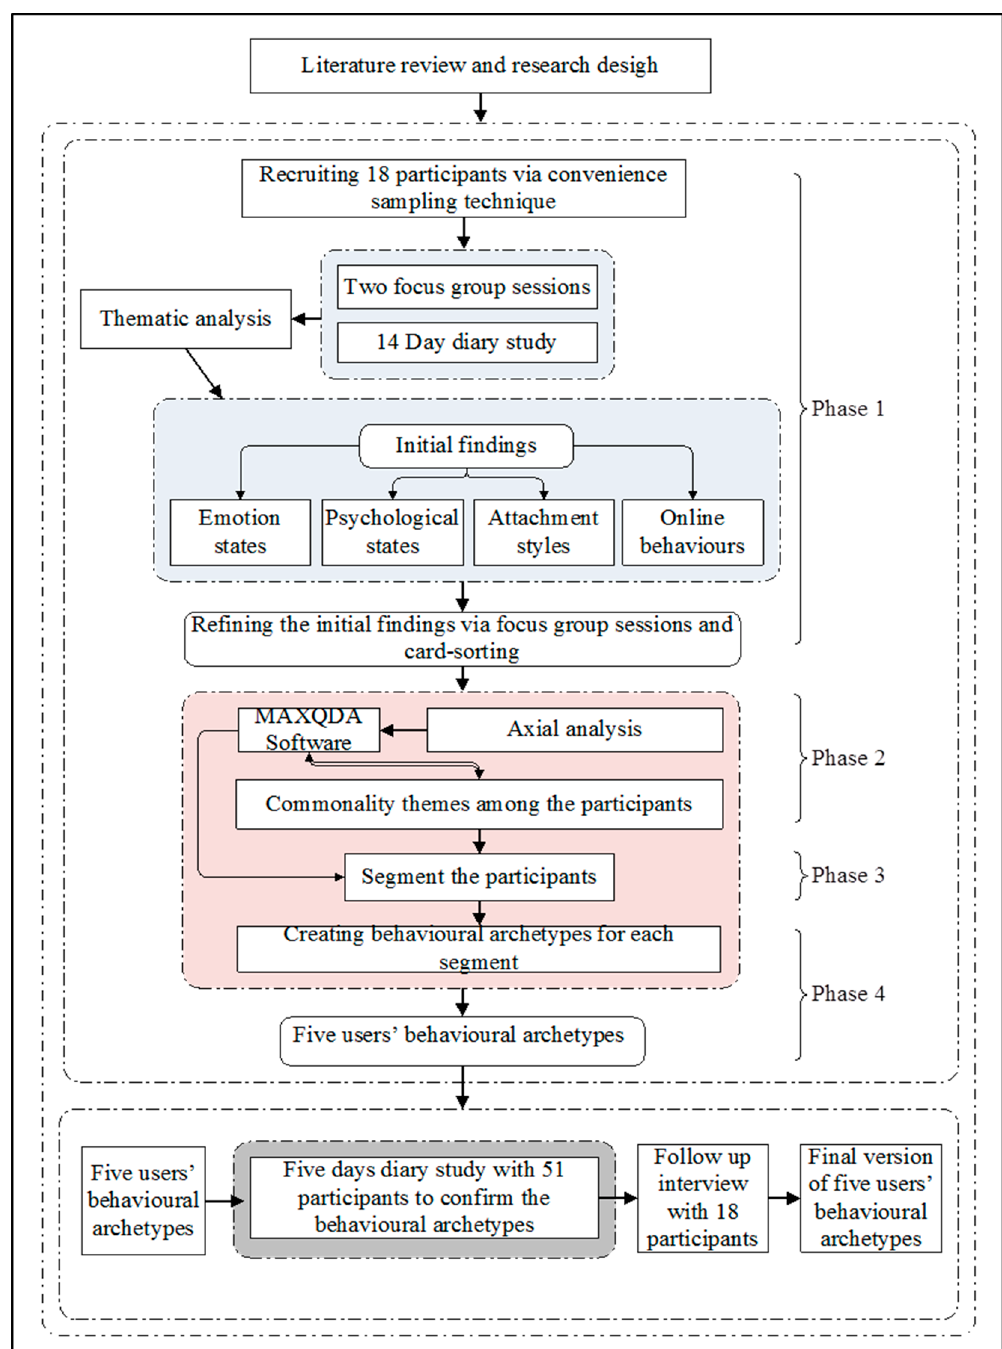
Figure 1. Overview of our research method and segmentation process.